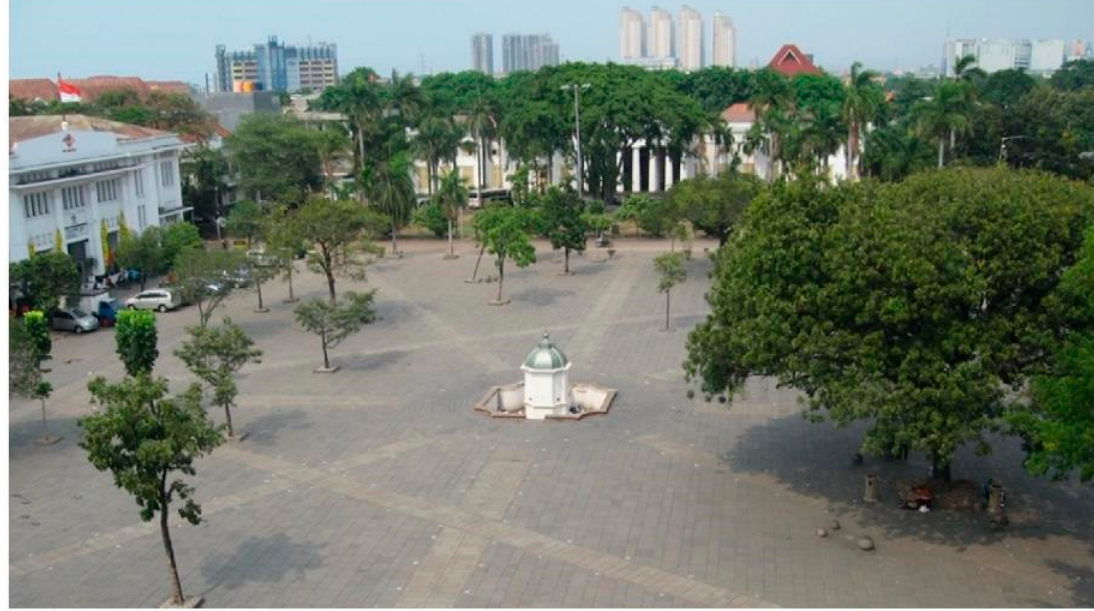
Figure 18. Trees in Fatahillah Square in 2016. Source: Private Collections of Attahiyyat.